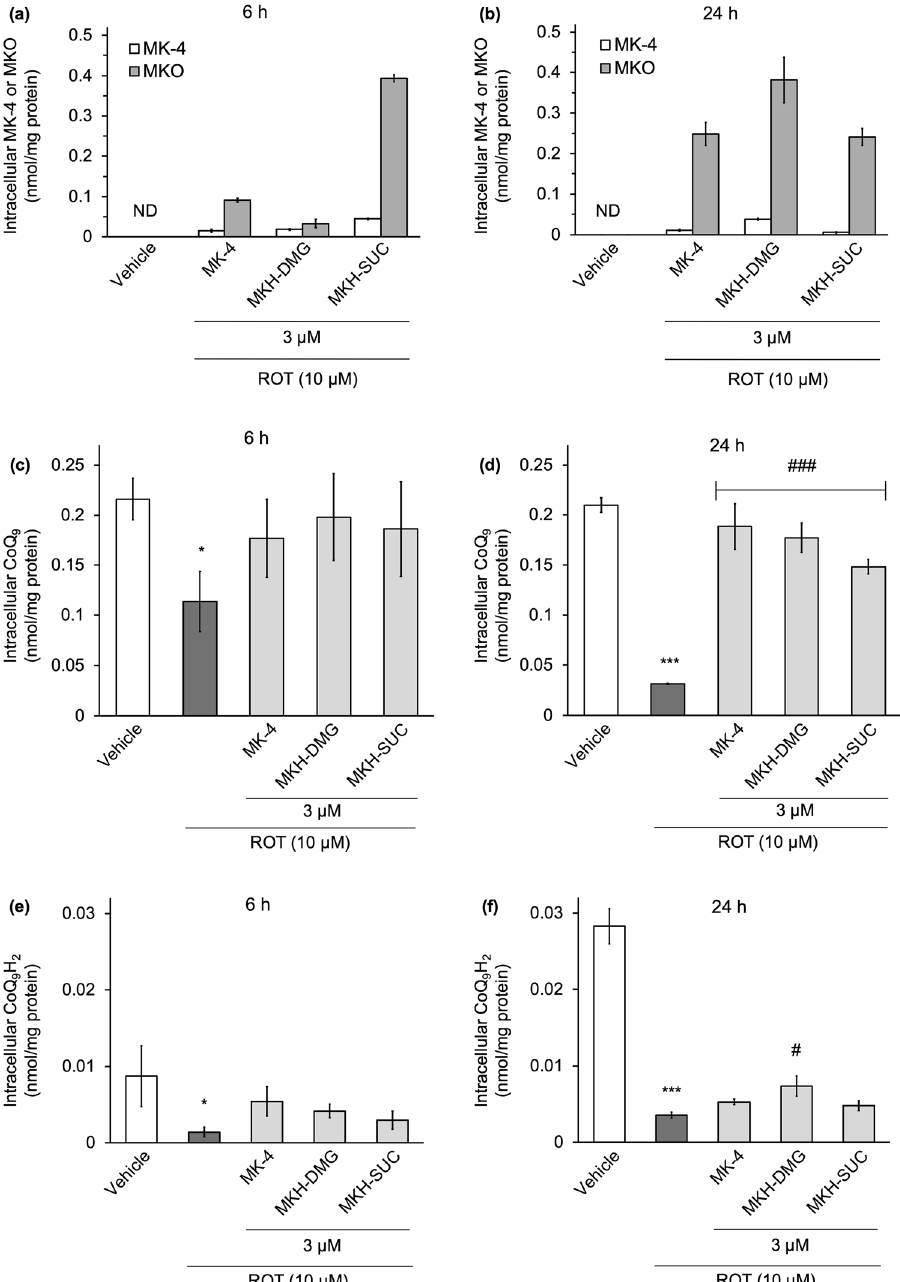
Figure 7. Intracellular MK-4, MKO, and native CoQ 9 /CoQ 9 H 2 levels in NIH/3T3 cells treated with ROT and MKH derivatives. The NIH/3T3 cells were treated with 3 µM MK-4, MKH-DMG, or MKH-SUC for 6 h or 24 h in the presence of 10 µM ROT. The intracellular levels of MK-4, MKO, CoQ 9 , and CoQ 9 H 2 were determined by LC–MS/MS. Intracellular MK-4 or MKO levels at ( a ) 6 h and ( b ) 24 h, CoQ 9 levels at ( c ) 6 h and ( d ) 24 h, CoQ 9 H 2 levels at ( e ) 6 h and ( f ) 24 h. ***p < 0.001 versus vehicle group; *p < 0.05 versus vehicle group; ### p < 0.001 versus ROT only group; #p < 0.05 versus ROT only group (Tukey’s test). Data are presented as mean ± SD (n =